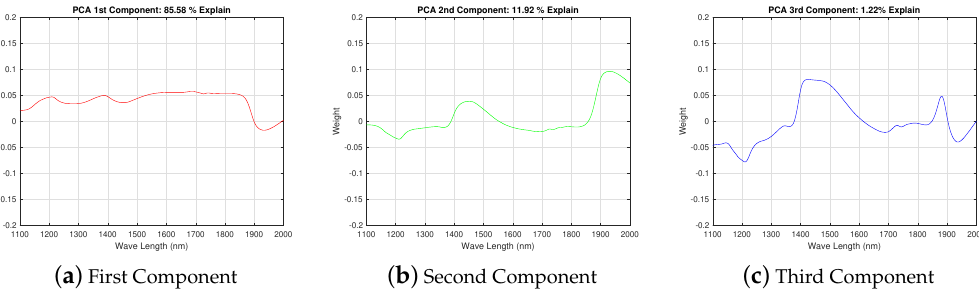
Figure 3. Loadings plot—Principal Components obtained by PCA from NIRS. The weights assigned to each one describes the relative influence for each wavelength.